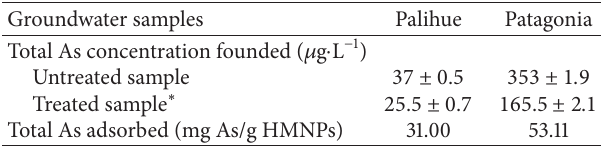
Table 2: Analysis of real groundwater samples. Groundwater